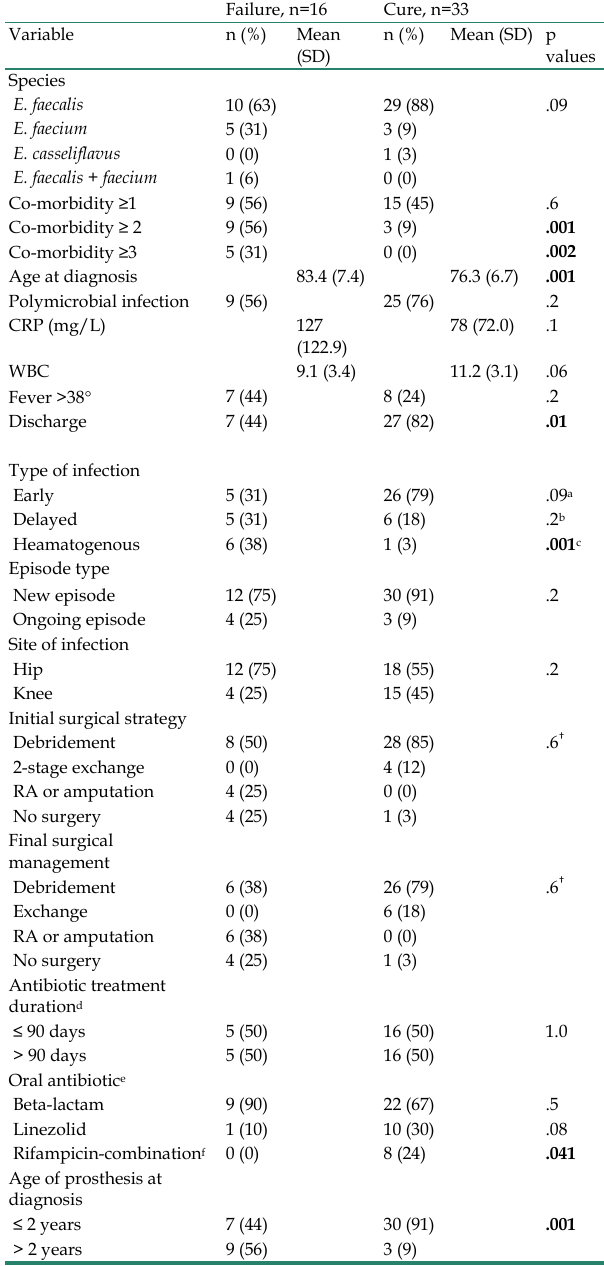
Failure, n=16 Cure, n=33 n (%) Mean (SD) p (SD) values